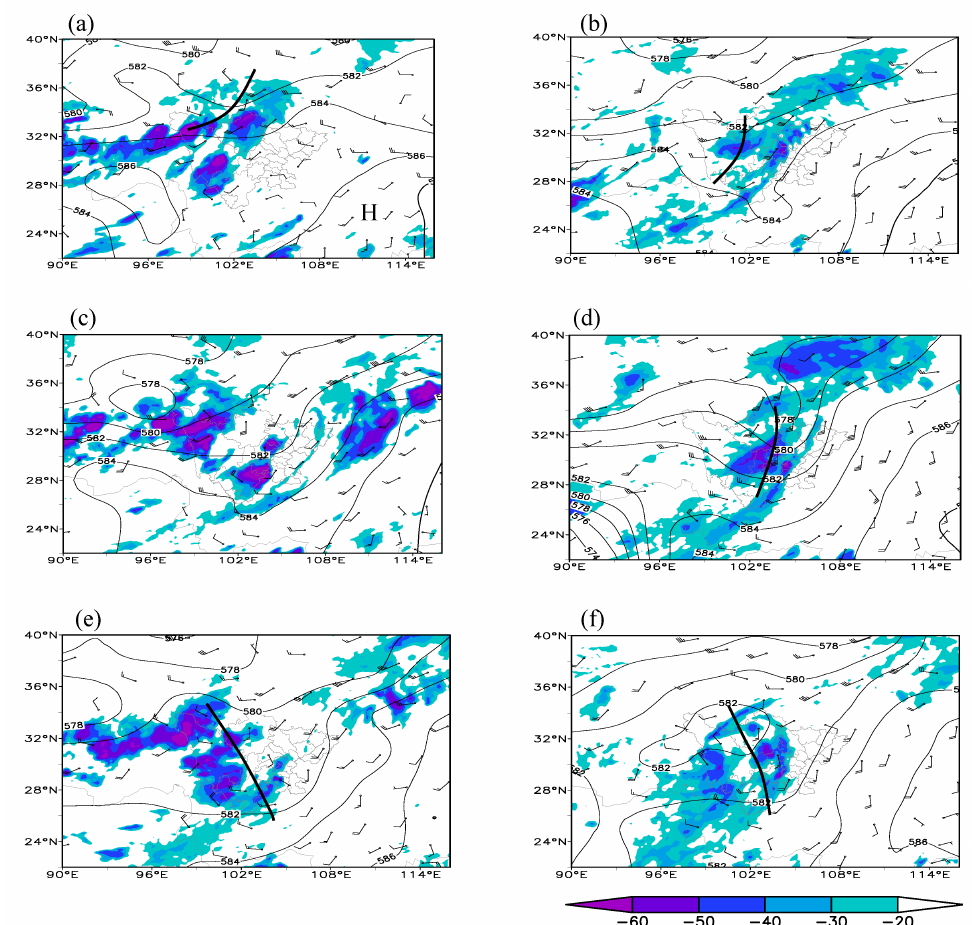
Figure 4. The 500-hPa geopotential height field (gpdam), wind field (m/s), and Tb (shaded: ◦ C) at ( a ) 1200 UTC 7 July, ( b ) 0000 UTC 8 July, ( c ) 1200 UTC 8 July, ( d ) 0000 UTC 9 July, ( e ) 1200 UTC 9 July, and ( f ) 0000 UTC 10 July. H: WPSH, the thick solid line: